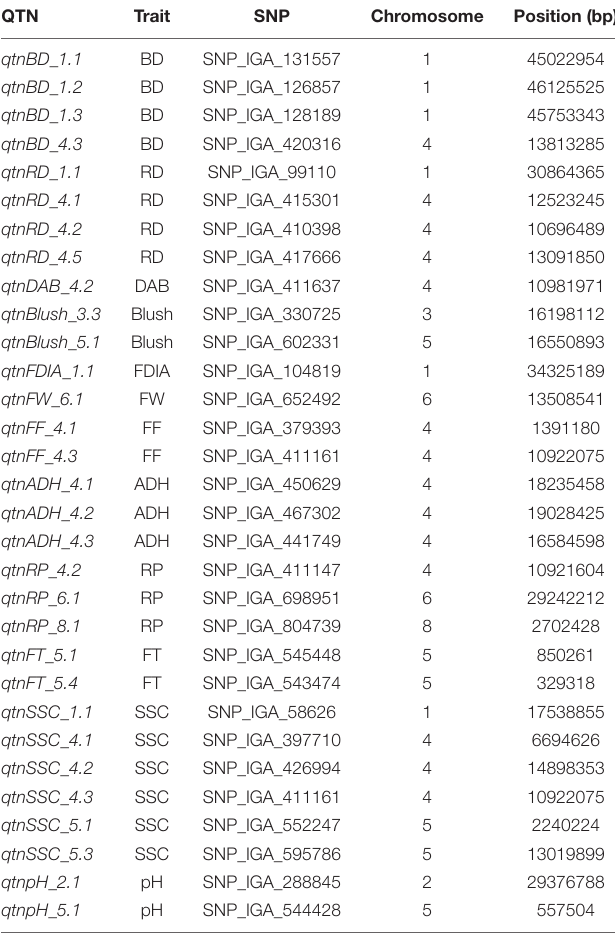
TABLE 4 | Significant associations between SNP markers and quality traits commonly detected using at least three mrMLM 4.0 GWAS methods and